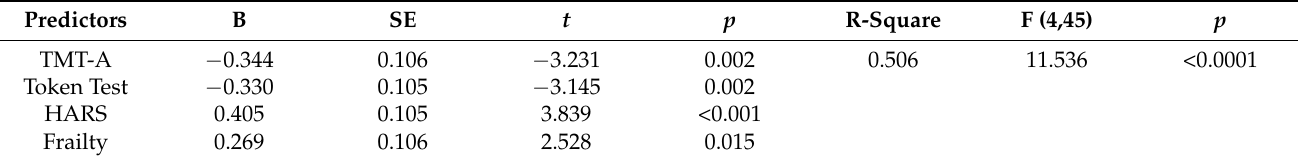
Table 5. Multiple linear regression analysis for predicting the perceived threat of SARS-CoV-2 contagion.